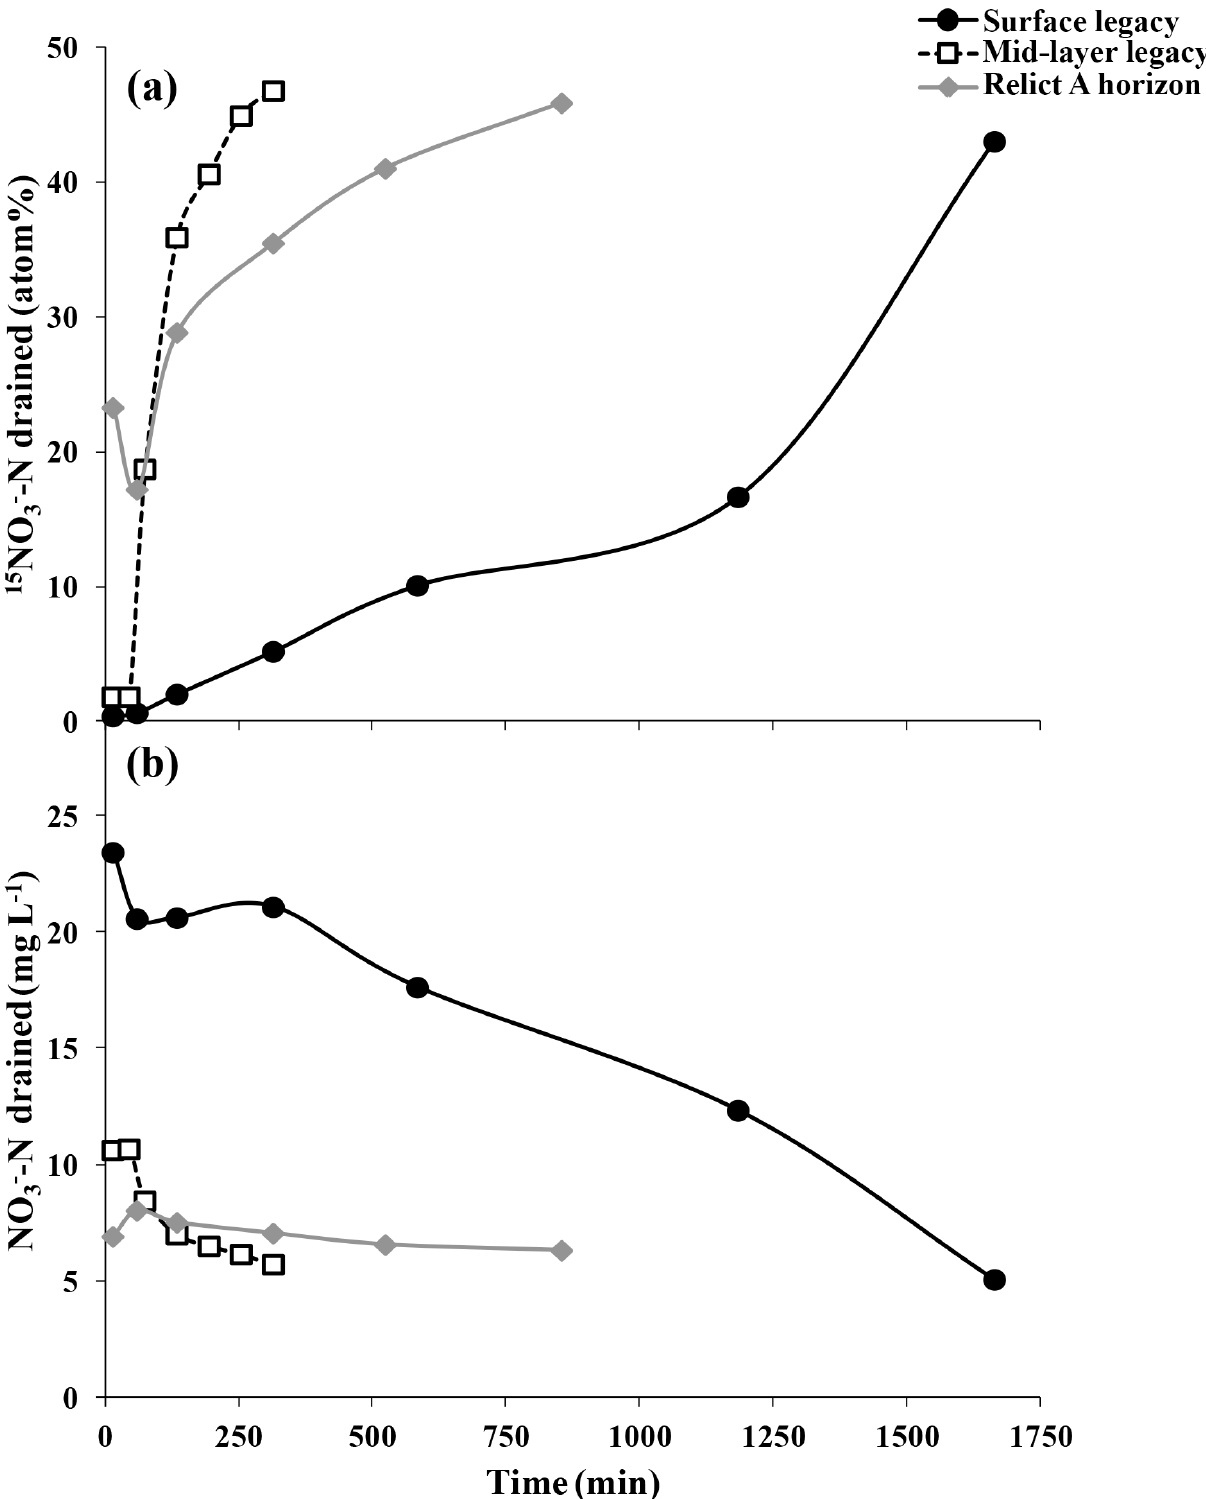
− and (b) NO − over time from one soil column of each of 3 3